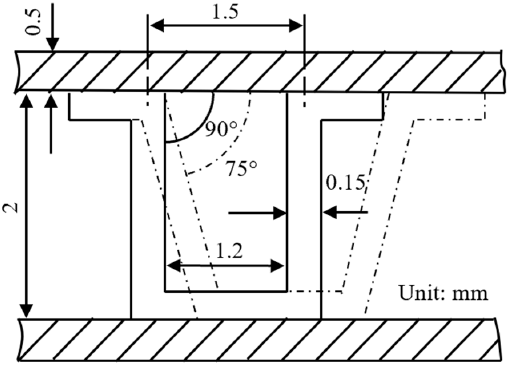
Figure 3. The solid line is 90-degree fin, and the dashed line is 75-degree